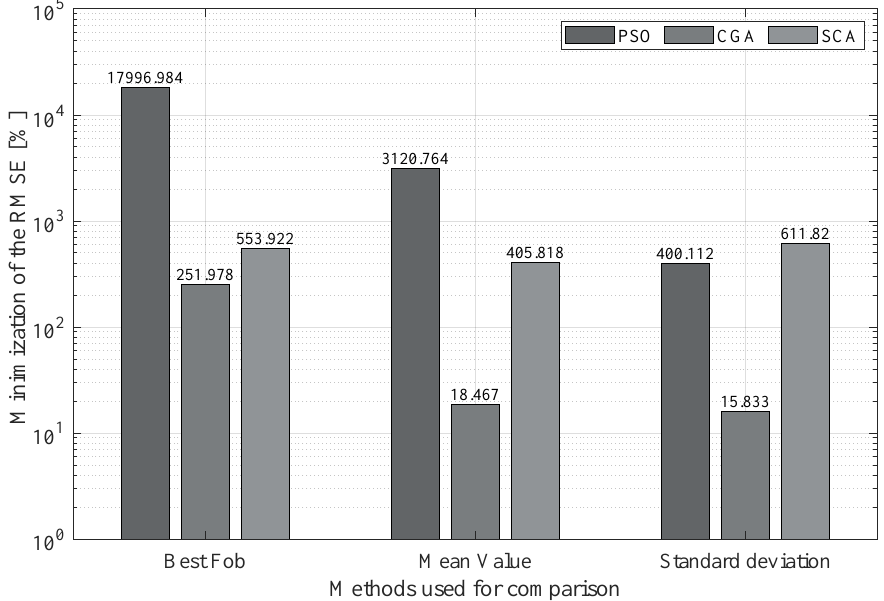
Figure 3. Minimization of the RSME in the TDM of a KC 200 GT PV panel under a 1000 W/m 2 irradiance level obtained by the SSA compared to other